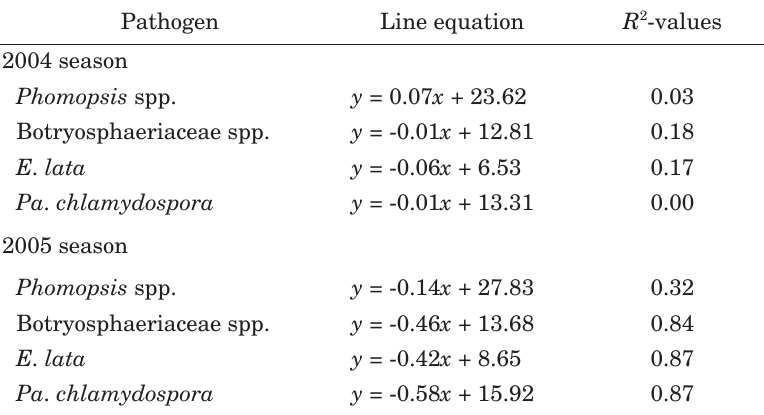
Table 2. Equations of linear trend lines fitted to the mean pathogen incidence in pruning wounds, which were made during July and August 2004 and 2005 and inoculated with Eutypa lata , Phaeomoniella chlamydospora , Neofusico- ccum australe and Phomopsis viticola directly after pruning, 1, 2, 3, 7, 10, 14, 17 and 21 days after pruning, over wound age at treatment for the significant year × pruning time × wound age at treatment interaction.